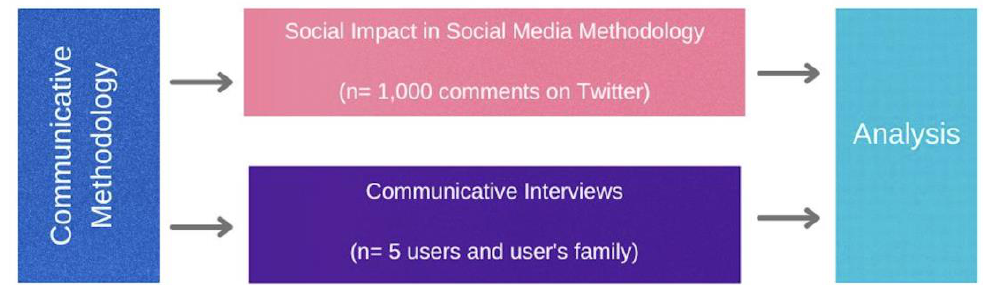
Figure 1. Flowchart of the data collection and analysis process.